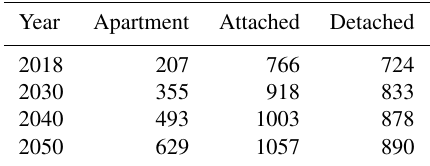
Table 7. Number of dwellings by type (in